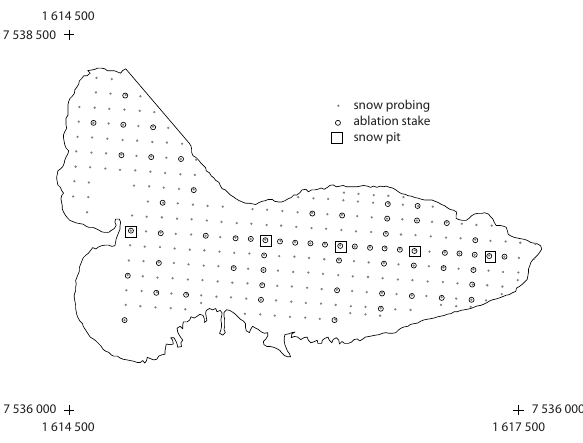
Fig. 1. Observation network on Storglaci¨aren in 2006/07. Snow observations and ablation stakes are used for the determination of the winter and summer mass balance, respectively. Glacier outlines from the 1990 map (Holmlund, 1996). Map coordinates are in the Swedish coordinate system RT 90 2.5 gon V.